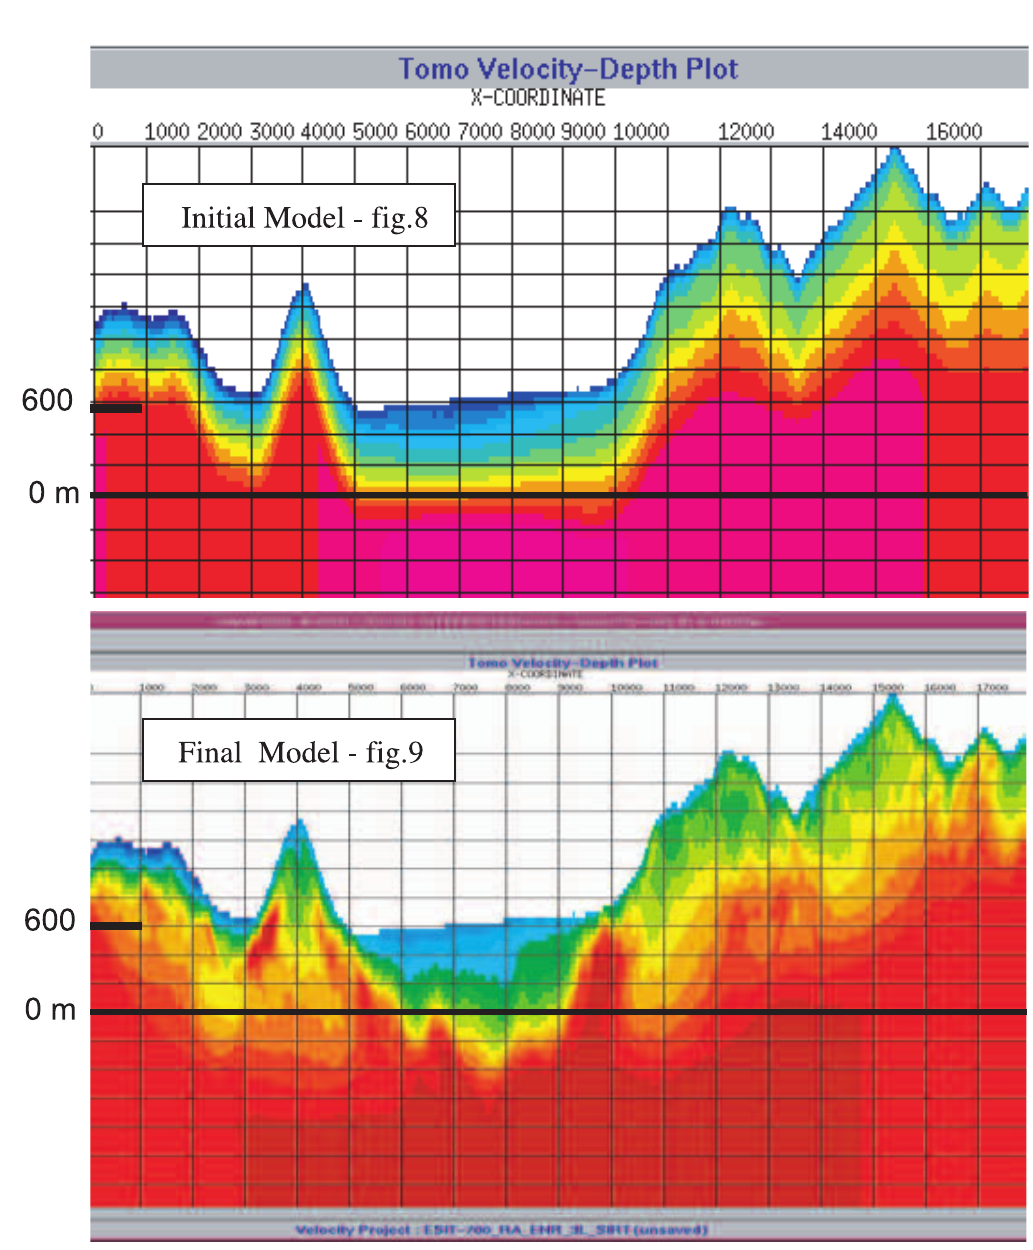
Figs. 8-9. Near surface tomography – initial and final velocity/depth